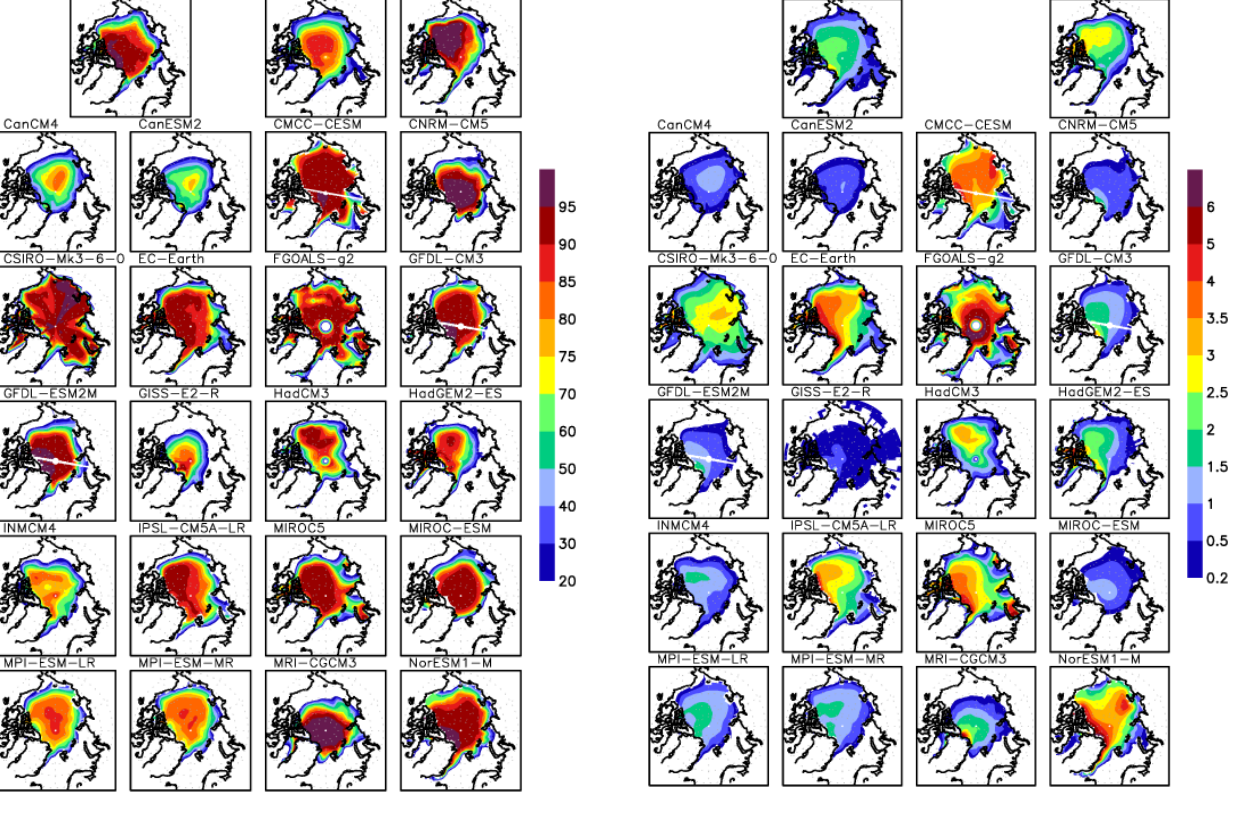
Fig. 2. September sea ice concentration in the OSISAF satellite product, CMIP5 ensemble mean and individual CMIP5 models, av- eraged over the period 1982–2005.